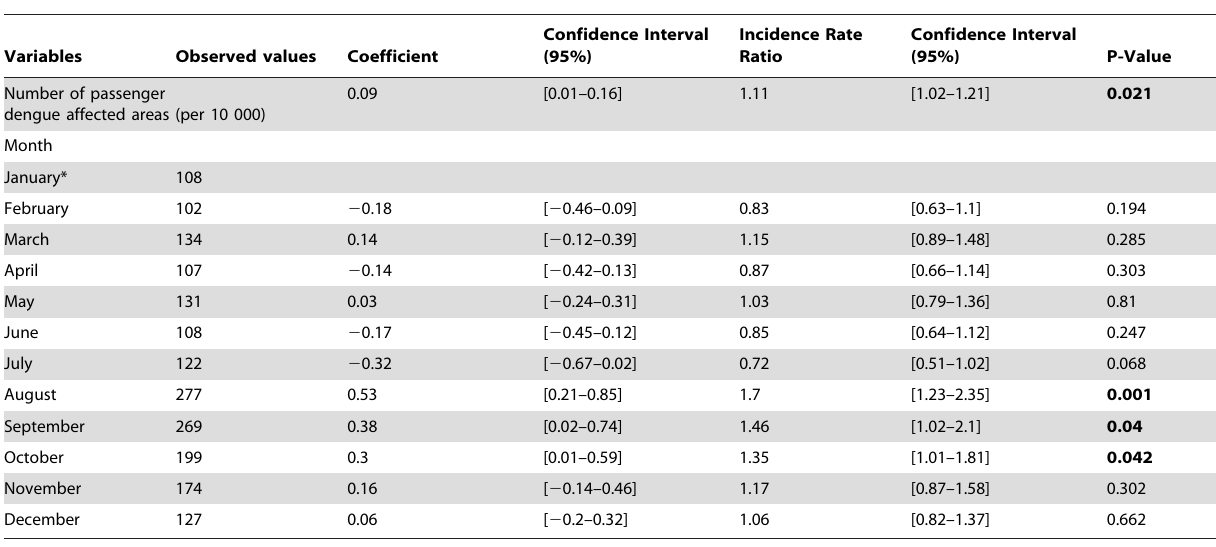
Table 2. Multilevel model for the estimation of the risk of dengue importation into Europe, by month,